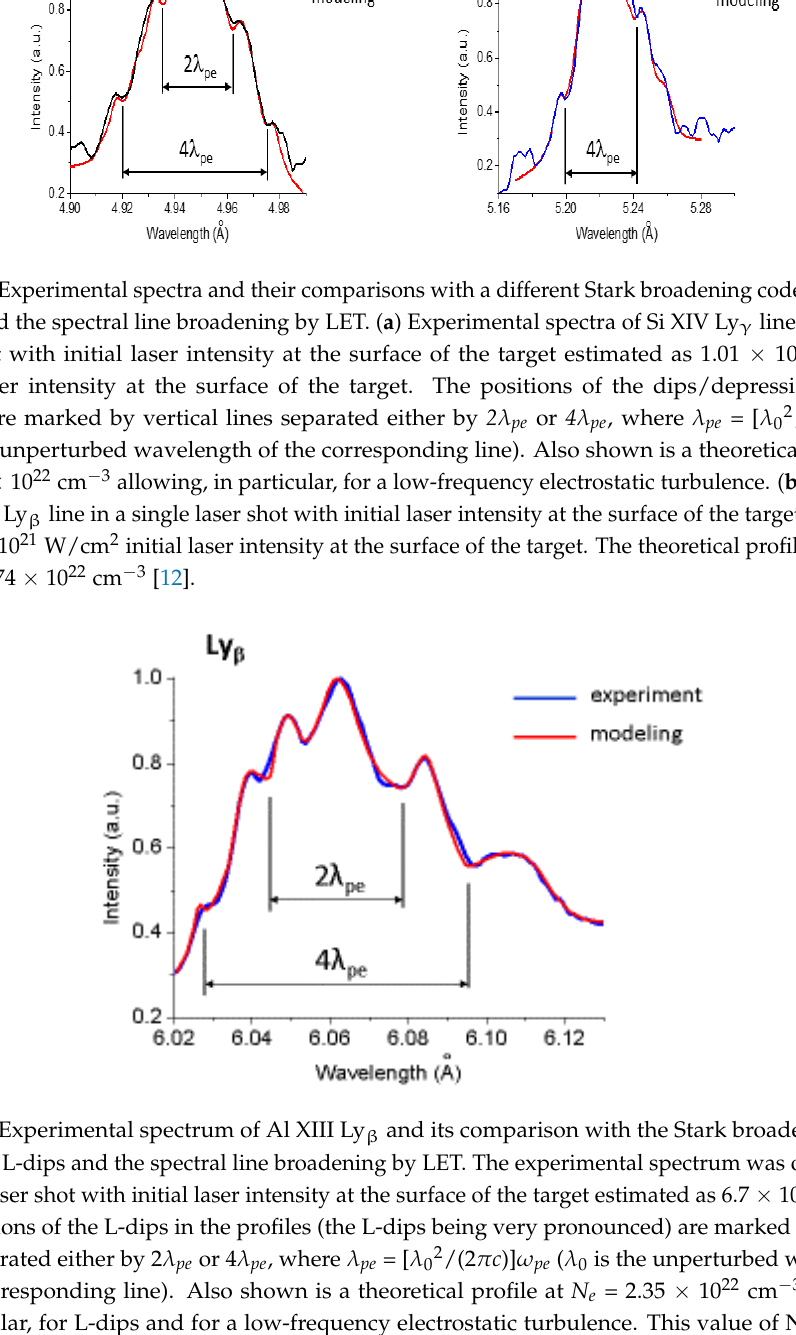
the unperturbed wavelength of the corresponding line). Also shown is a theoretical profile at N e = 3.6 × 10 22 cm −3 allowing, in particular, for a low-frequency electrostatic turbulence. ( b ) Same but for Si XIV Ly β line in a single laser shot with initial laser intensity at the surface of the target estimated as 0.24 × 10 21 W/cm 2 initial laser intensity at the surface of the target. The theoretical profile is shown at N e = 1.74 × 10 22 cm −3 [12].